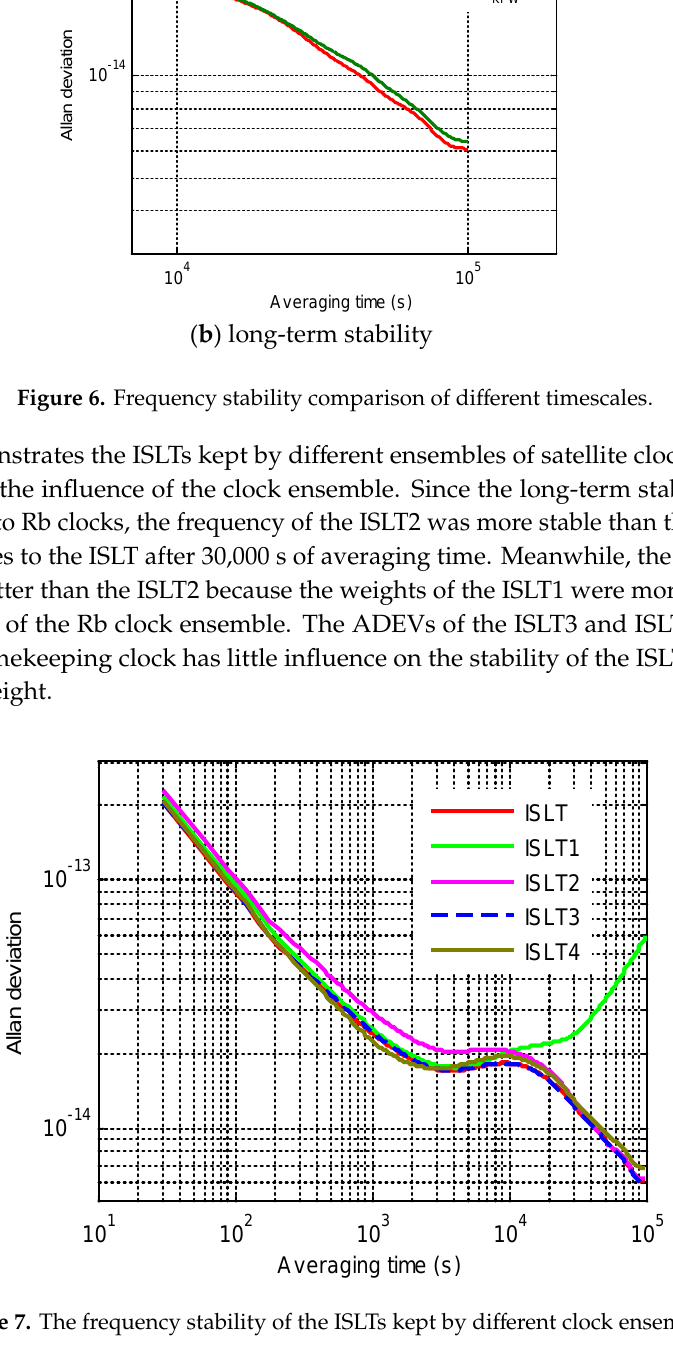
Figure 7. The frequency stability of the ISLTs kept by different clock ensembles. Table 3. The ensemble of satellite clocks that kept the